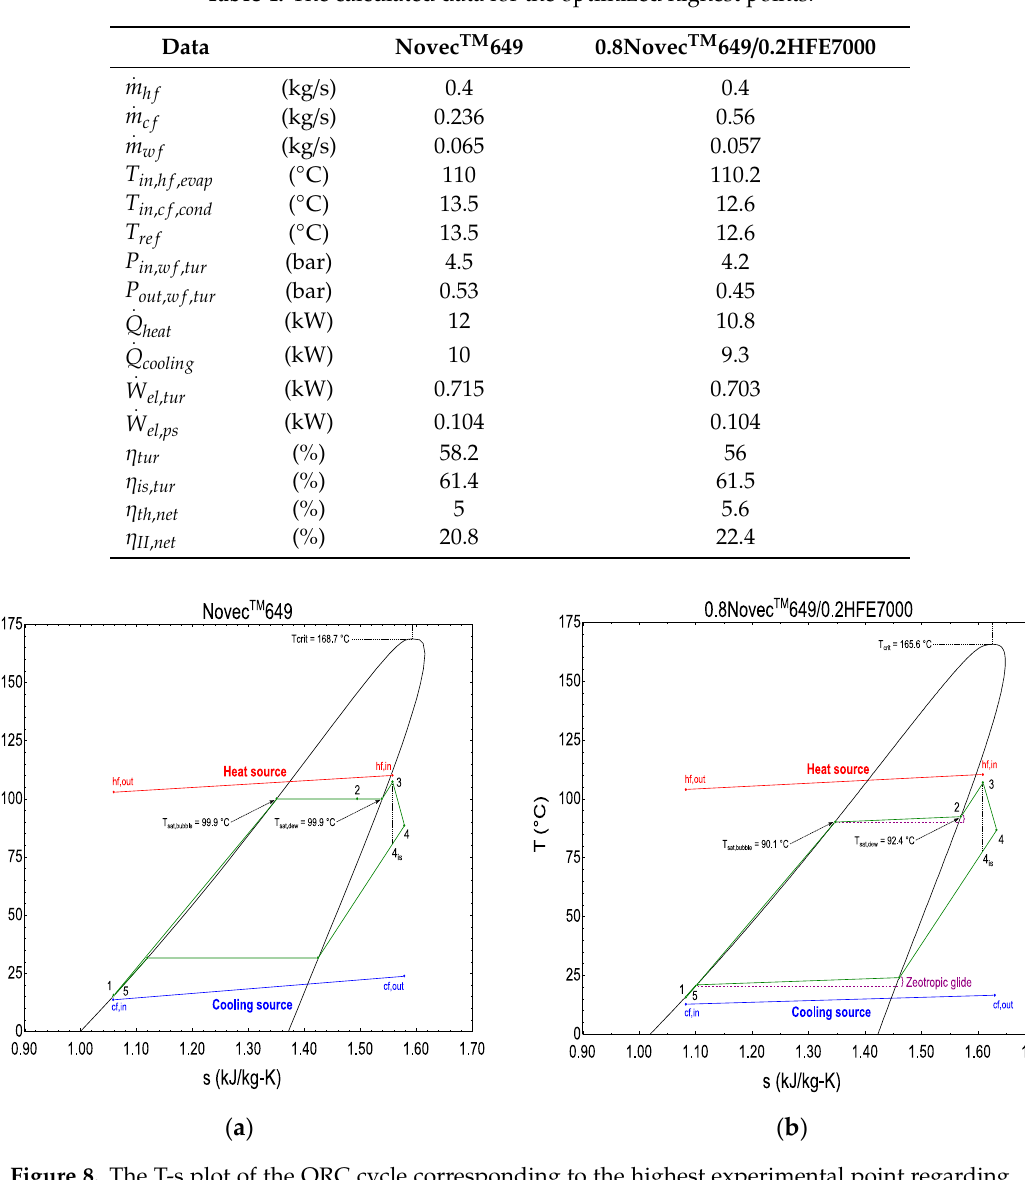
Figure 9. The ORCs’ distribution according to their gross thermal efficiency. 409